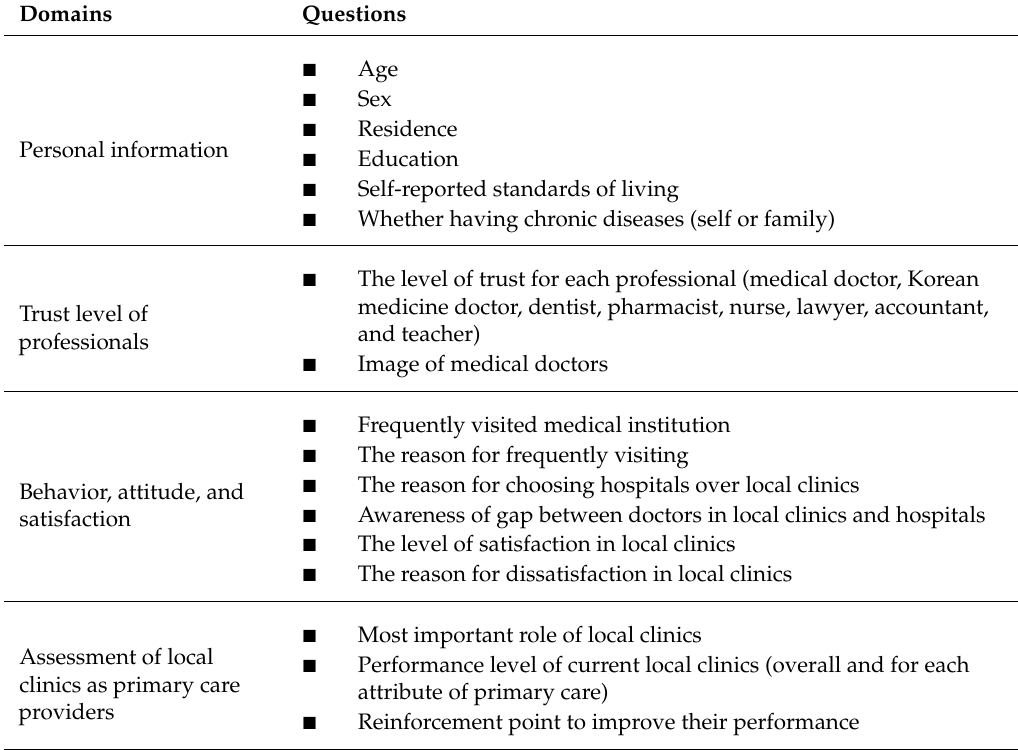
Table 1. Summary of